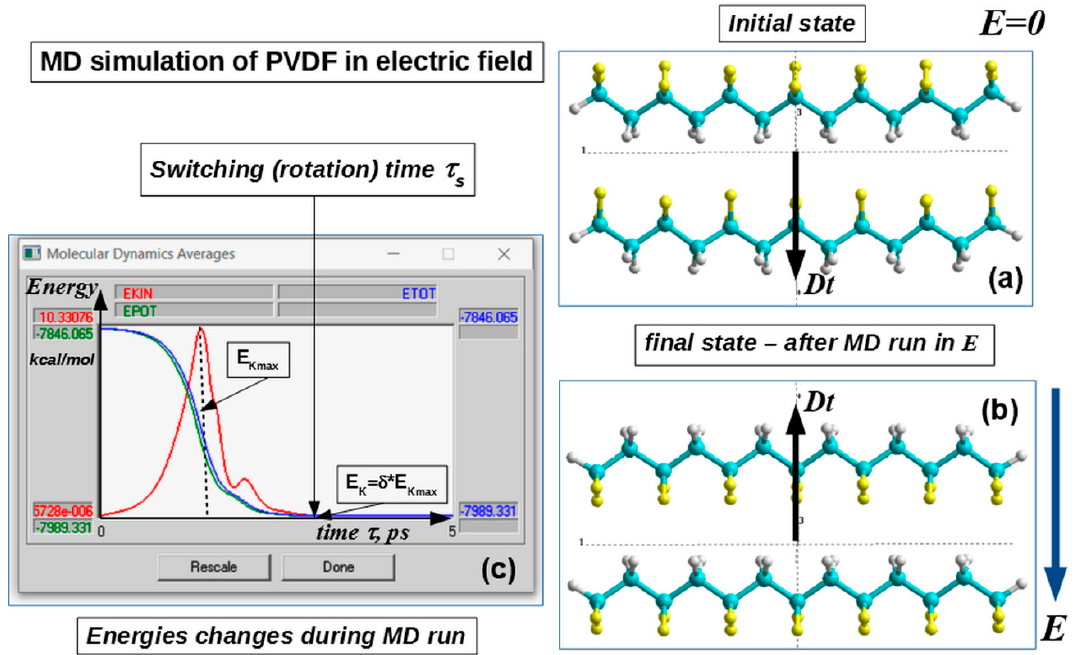
Figure 2. Scheme of the MD run process for a 2 PVDF-6 chains model with PM3 (in restricted Hartree-Fock approximation–RHF) calculations at each MD run step: ( a ) initial state; ( b ) final state after the MD run with dipole moment D orientation turned (switched) in the opposite direction in the electric field E; ( c ) changes of the MD average energies trajectory over time during the MD run (in ps) and the time of the switching τ s for this PVDF system (red–kinetic energy, blue–total energy, green–potential energy). Reproduced with permission from [18]; Elsevier, 2014.